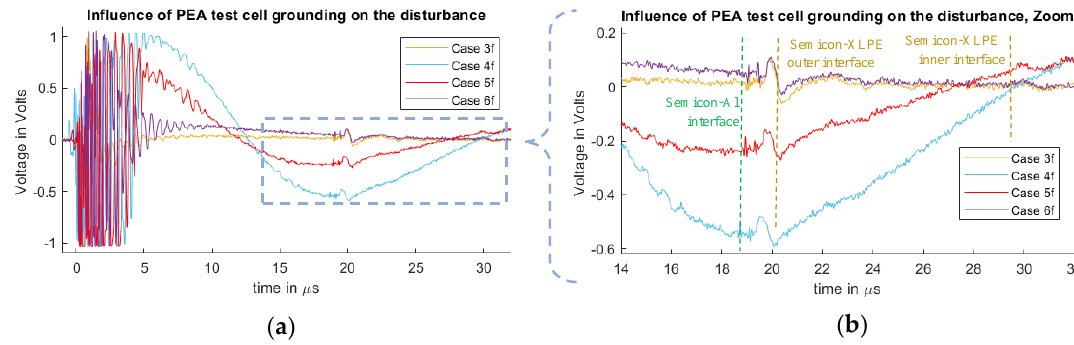
Figure 10. Measured disturbance from Cases 3f, 4f, 5f and 6f. ( a ) Full measured signal ranging from the instant of the pulsed voltage application up to 32 µs. ( b ) Zoom to the time instant of the acoustic signal arrival belonging to the charge measurements.